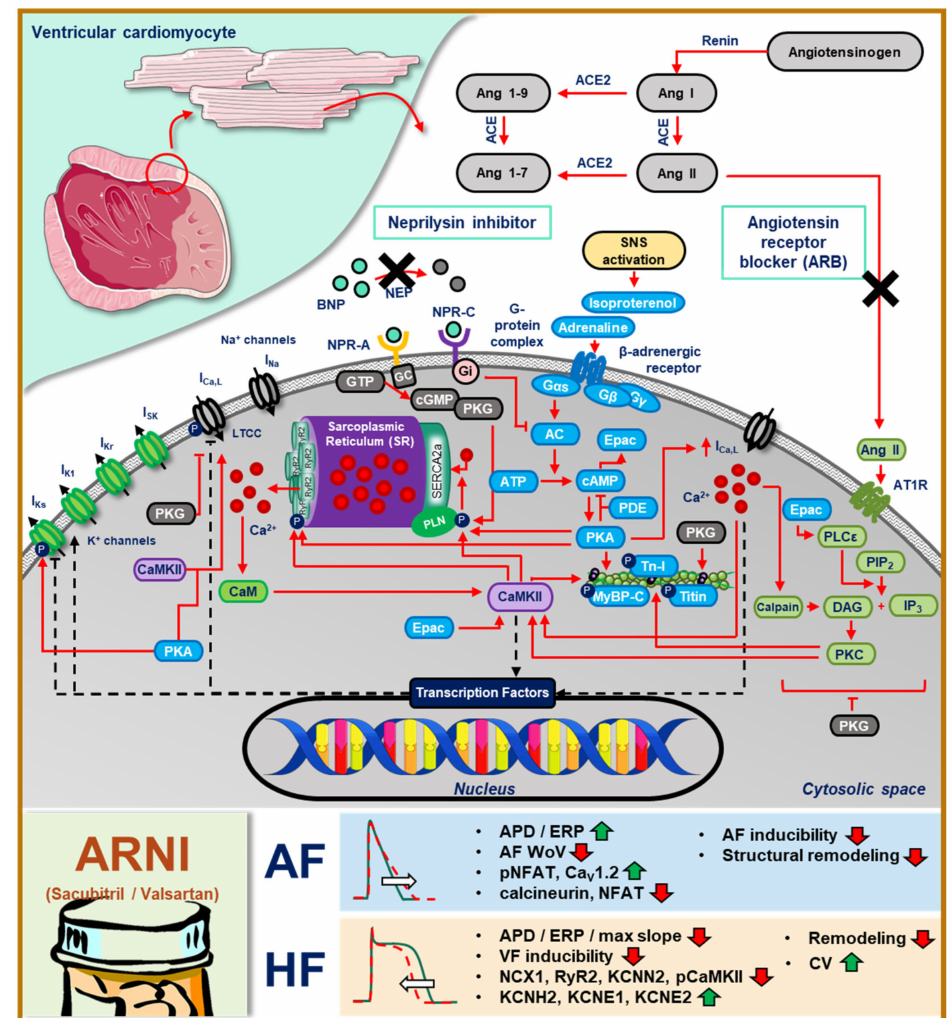
Figure 4. The overview of calcium-dependent signaling cascades in ventricular cardiomyocytes and the beneficial effects of ARNI in modulating cardiac electrophysiology. (AC = adenylyl cyclase; ACE = angiotensin converting enzyme; Ang II = angiotensin II; APD = action potential duration; ATP = adenosine triphosphate; CaM = calmodulin; CaMKII = calmodulin-dependent protein kinase II; cAMP = cyclic adenosine monophosphate; CV = conduction velocity; DAG = diacyl glycerol; ERP = effective refractory period; GC = guanylyl cyclase; IL = interleukin; IP 3 = inositol trisphos- phate; MyBP-C = myosin binding protein C; NEP = neprilysin; NFAT = nuclear factor of activated T-cells; NPR = natriuretic peptide receptor; PDE = phosphodiesterase; PIP 2 = phosphatidylinos- itol bisphosphate; PKA = protein kinase A; PKC = protein kinase C; PKG = protein kinase G; PLC = phospholipase C; Tn-I = troponin I; WoV = window of